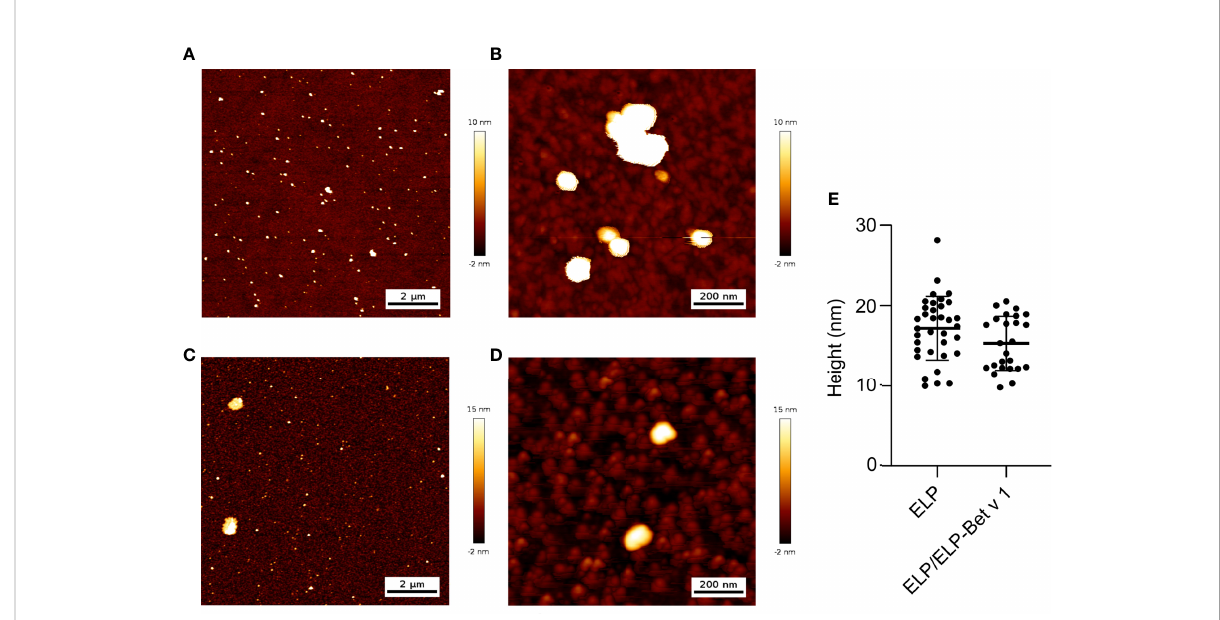
FIGURE 3 AFM images and analysis of ELP (A, B) and ELP/ELP-Bet v 1 (C, D) . Polypeptide solutions in water were heated to 37°C and deposited on a silicon oxide surface. The samples were dried at 37°C and imaged using height trace mode at medium (A , C) , high (B, D) and low (Figure S6) magni fi cations. The medium magni fi cation was used to analyze the average height of the imaged micelles (E) : 17.1 nm (ELP) and 15.3 nm (ELP/ ELP-Bet v 1). Error trace versions of these images are depicted in Figure S6. Control images and images of the samples on mica are compiled in Figure S7.